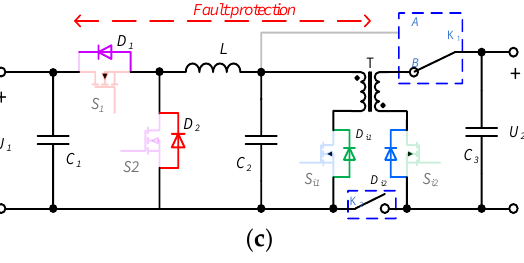
Figure 5. Three operating states of the isolated mode: ( a ) forward conversion stage; ( b ) reverse conversion stage; and ( c ) fault protection stage.